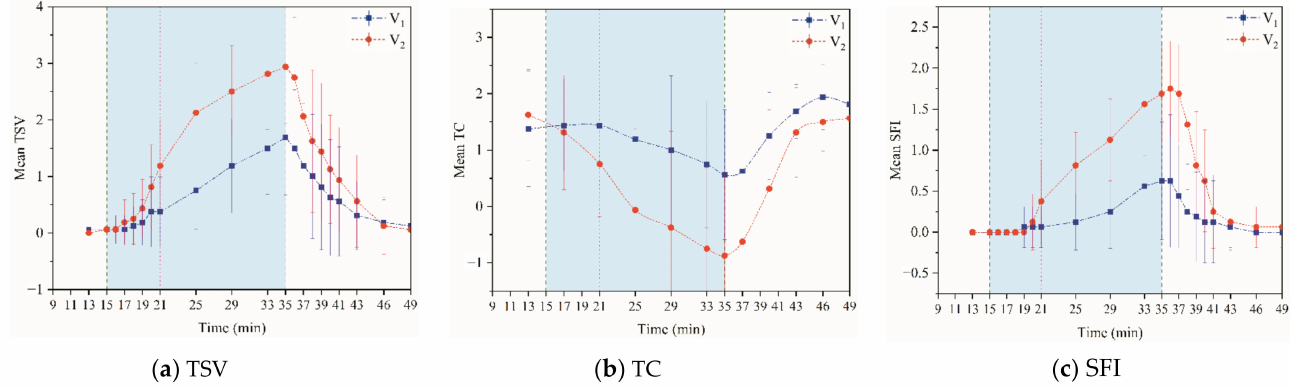
Figure 7. Multiple lines of mean TSV, TC and SFI by time and